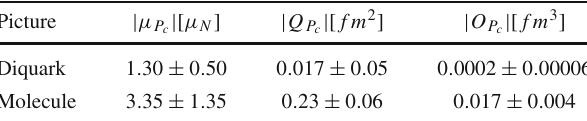
Table 1 Results of the magnetic dipole, electric quadrupole and mag- netic octupole moments of P c pentaquark